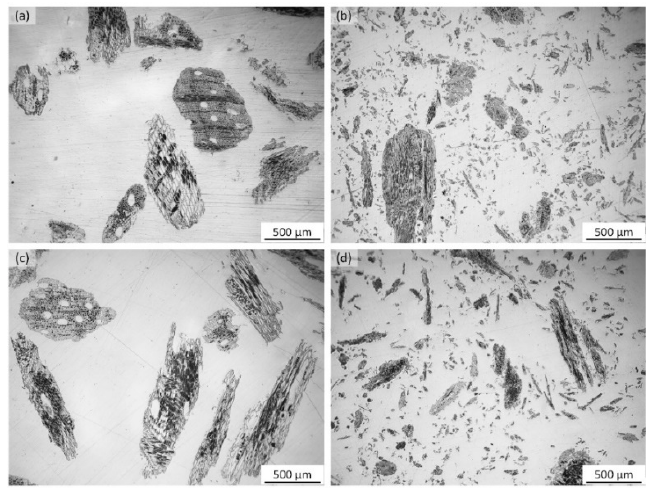
Figure 1. Optical microstructures of: ( a ) HW, ( b ) HW:M, ( c ) HW:A and ( d ) HW:(A + M).